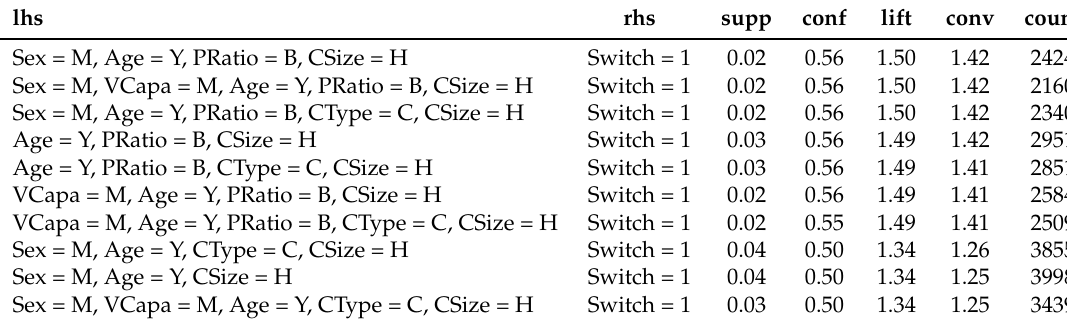
Table 7. Association rules for switch with policy characteristics, claim size, and premium ratio.